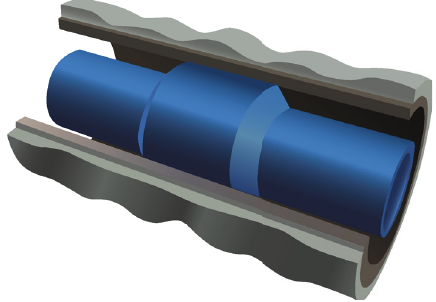
Figure 1: Geometry of the drillstring joint.